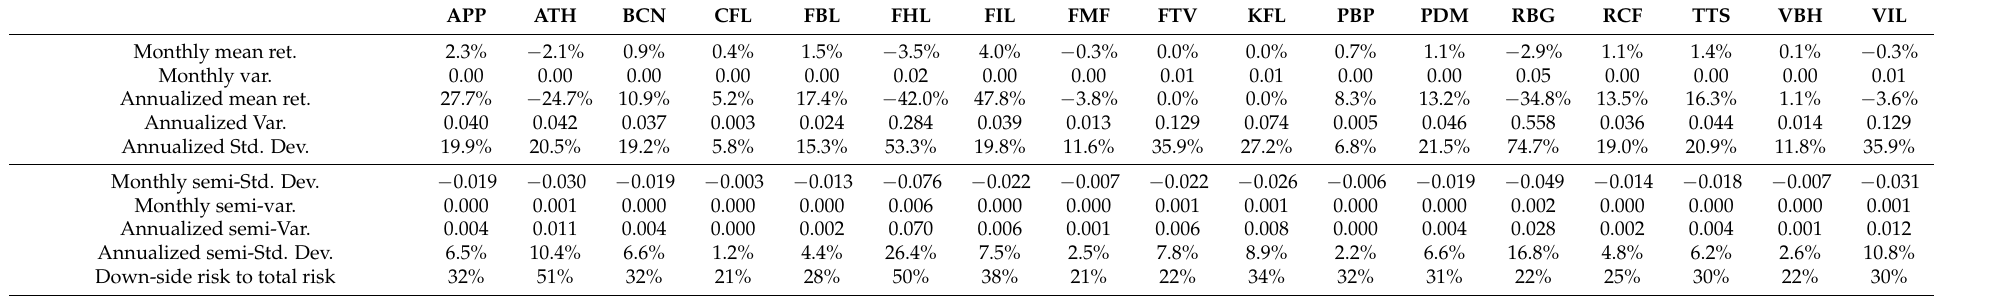
Table 15. Monthly and Annualized Returns and Standard Deviations. APP ATH BCN CFL Monthly mean ret.